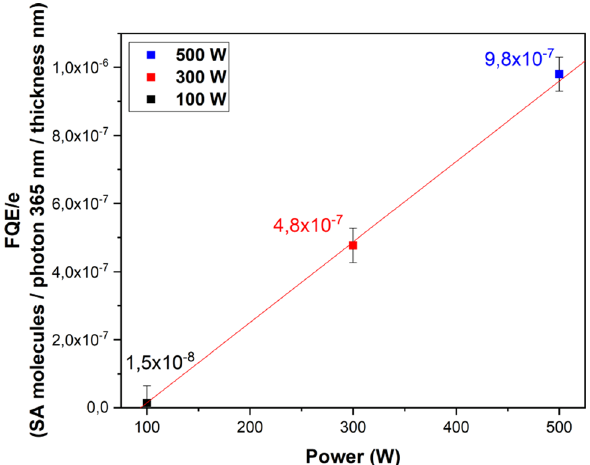
Figure 3. : Normalized photocatalytic efficiency (SA molecules/photon 365 nm/coating thickness) as a function of RF Power